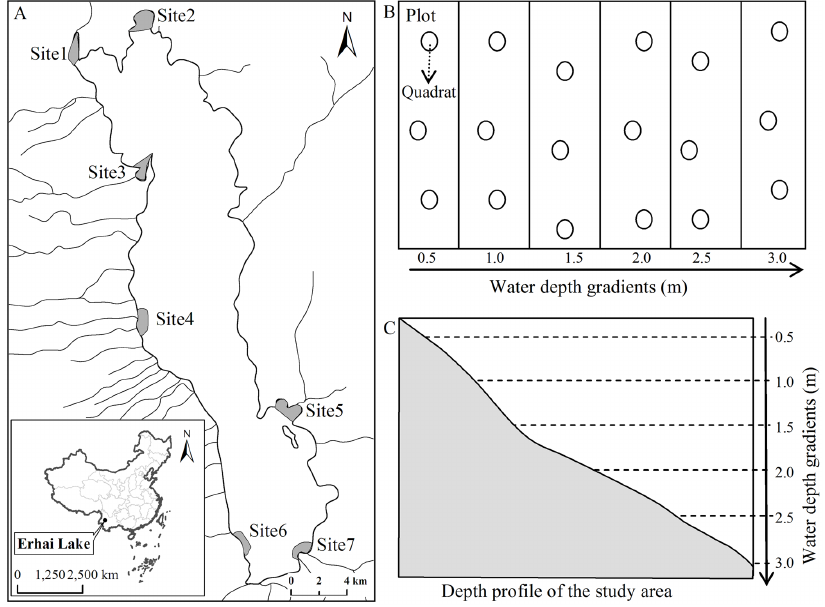
Fig 1. The study location and scheme of the sampling design. (a) The study was carried out in Erhai Lake (25°52'N, 100°06'E) in Yunnan Province, China. We sampled macrophyte communities in forty-two 25 m 2 plots at seven sites. At each site, six 5 × 5 m plots were located along the water depth gradient at 0.5 m intervals from 0 m to 3.0 m depth (b, c). Within each 25 m 2 plot, we used three 0.2 m 2 quadrats for this analysis